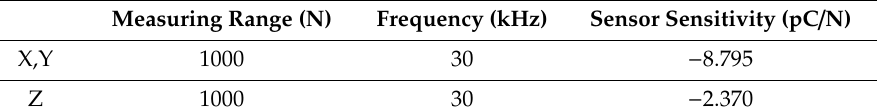
Table 5. The measurements parameters of piezoelectric dynamometer.